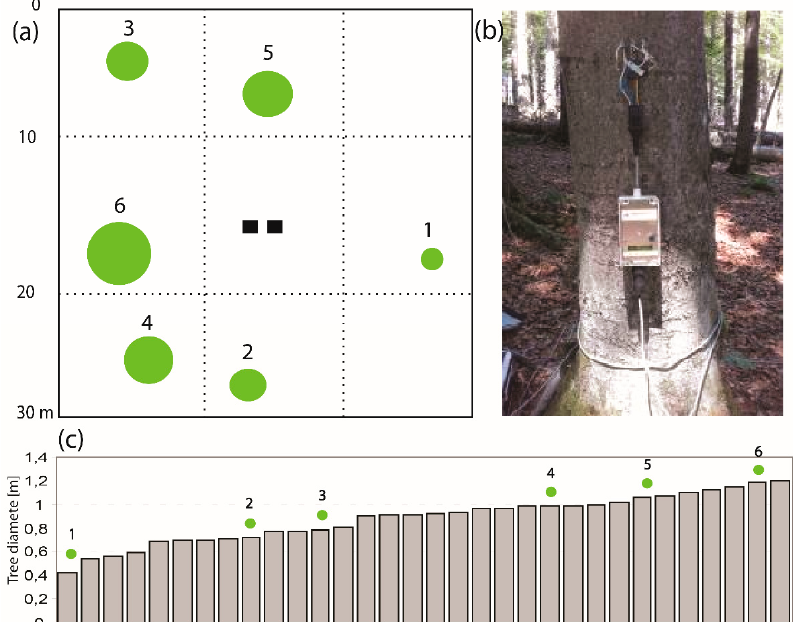
Figure 3. ( a ) Scheme of the tree distribution for sap flow measurement at the 30 × 30-m experimental plot. Note: the size of the green dot represents the size of the tree trunk, two black squares are the rough location of two tensiometers. ( b ) Photo of one installed EMS 81 sap flow device at 1 m above the ground in Tree No. 1. ( c ) Tree trunk diameter (in m) distribution at 1-m height within 32 beech trees over the experimental plot. Note: the green dots mark the measured trees.